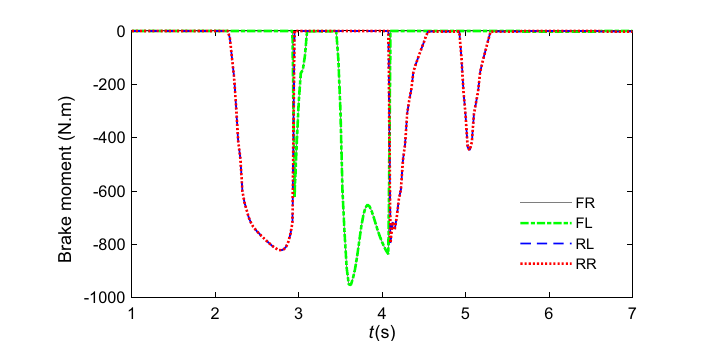
Figure 19. Active braking torque of 4 wheels by AMPC.